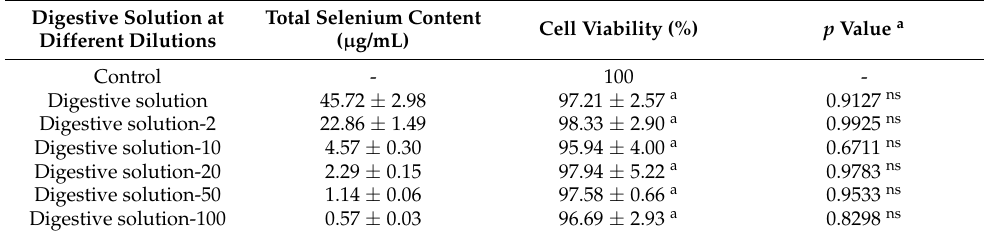
Table 2. Cytotoxicity of digestive solutions at different